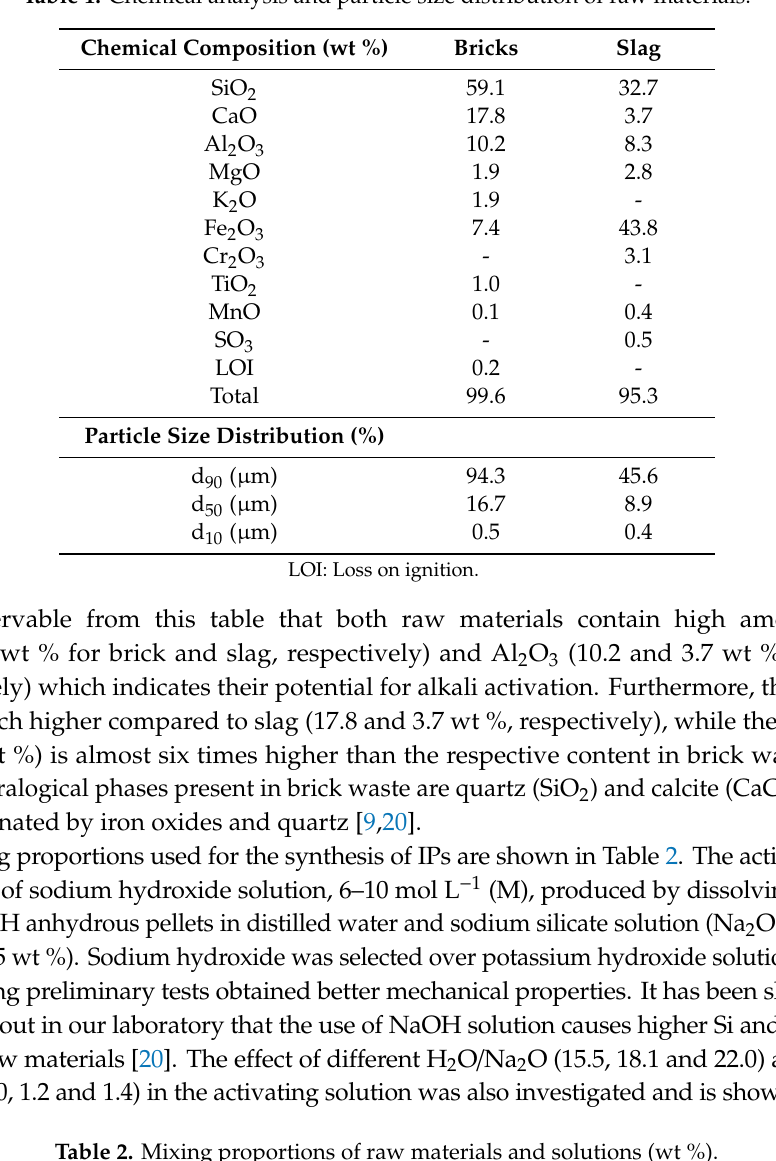
Table 2. Mixing proportions of raw materials and solutions (wt %). IP Code